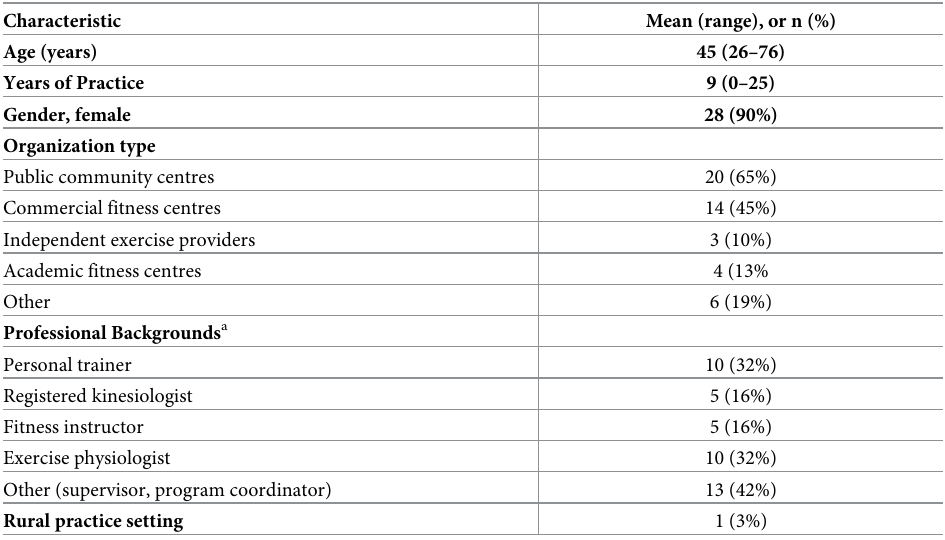
Table 1. Study participant